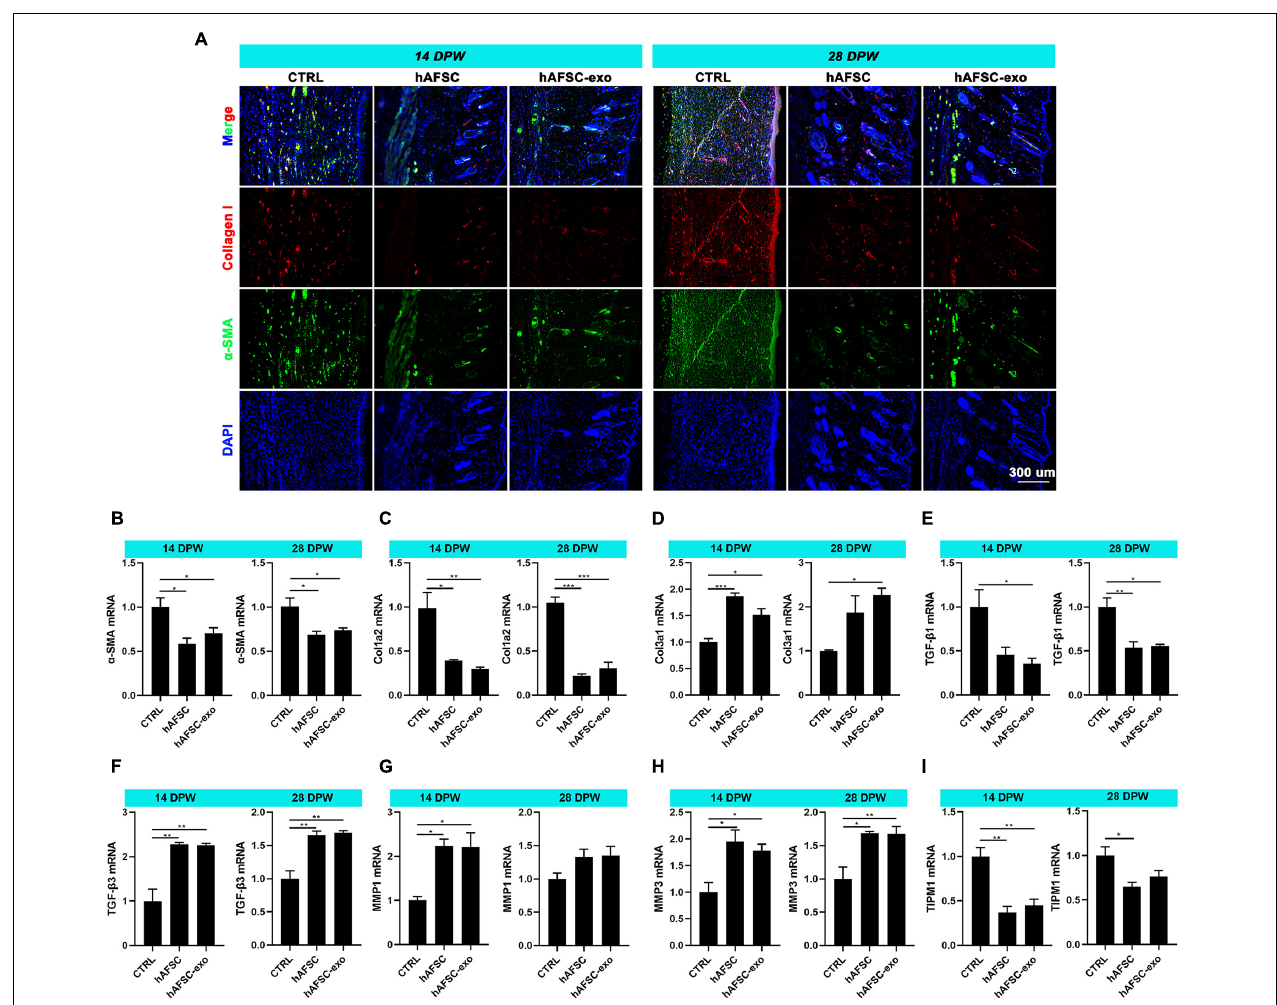
FIGURE 4 | hAFSC-exo suppress myofibroblast aggregation on wound healing in rats. (A) IF staining of α -SMA and collagen I in the healed tissues (scale bar = 300 µ m). (B–I) mRNA levels of α -SMA, Col1a2, Col3a1, TGF- β 1, TGF- β 3, MMP1, MMP3, and TIMP1 in the healed tissues. * P < 0.05; ** P < 0.01; *** P < 0.001; mean ± SD; n = 5. α -SMA, α -Smooth muscle actin; MMP1, matrix metalloproteinase 1; MMP3, matrix metalloproteinase 3; TGF- β 1, transforming growth factor- β 1; TGF- β 3, transforming growth factor- β 3; TIMP1, tissue Inhibitor of metalloproteinases